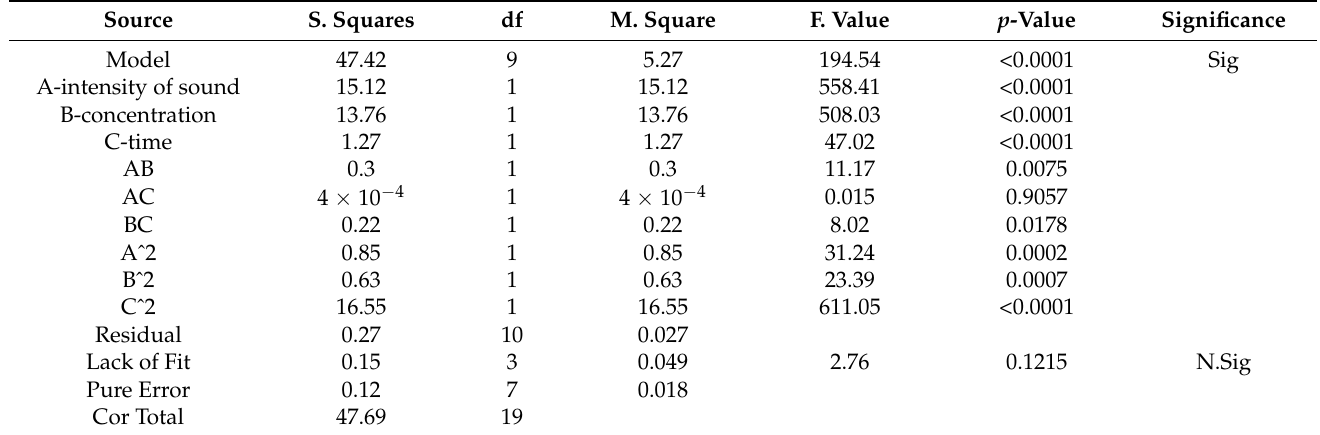
Table 4. ANOVA results for Folin–Ciocalteau extraction.